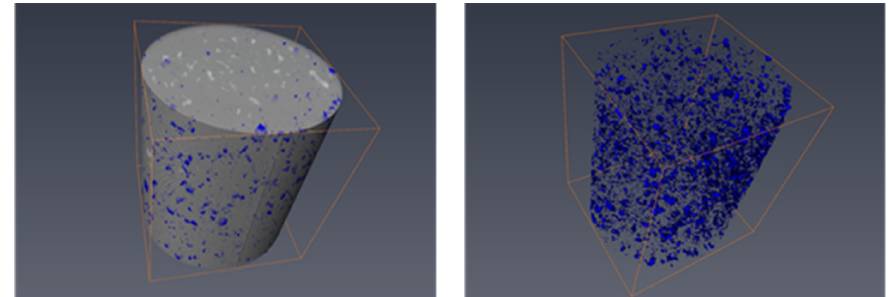
Figure 4. The initial dry sample (blue represents the pores of the rock sample).